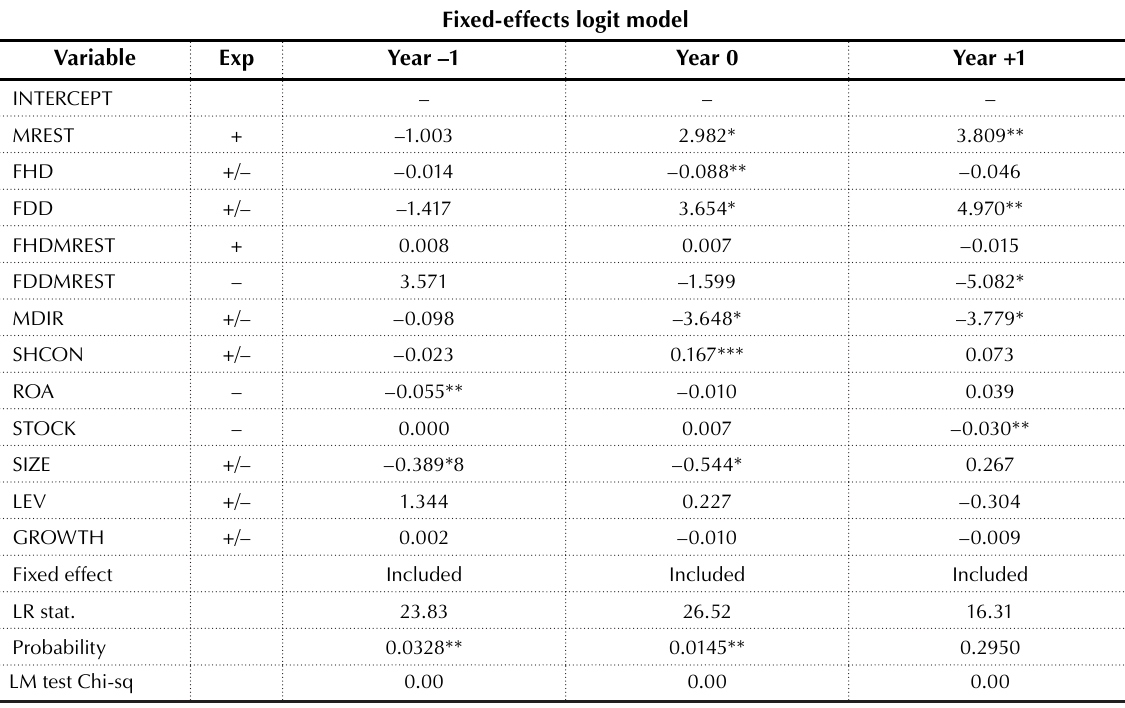
Table 4. Turnover before, in and after the year of mandatory restatement